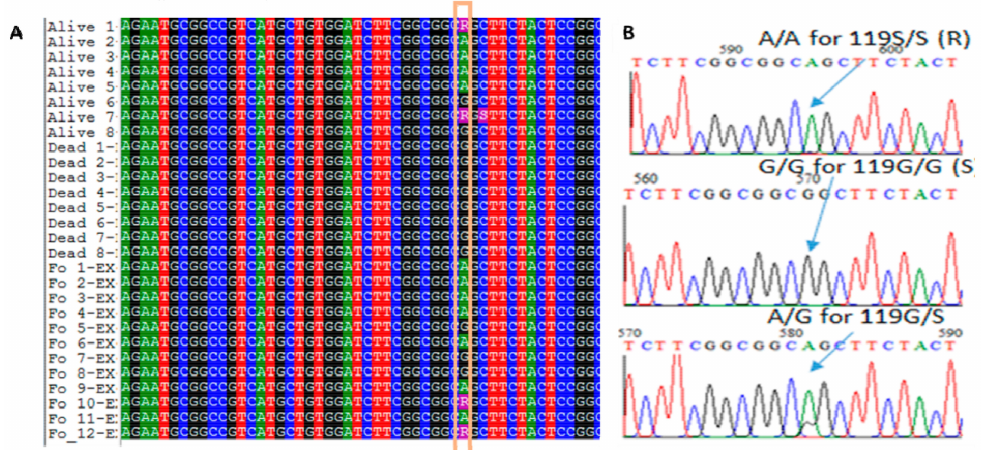
Figure 3. Sequencing of the portion of the Ace-1 gene spanning the G119S mutation. ( A ) Sequence alignment of the Ace-1 gene at the G119S point mutation in field collected adult mosquitoes (F 0 ), F 1 alive, and dead mosquitoes 24 h after exposure to bendiocarb. R represents the heterozygote genotype